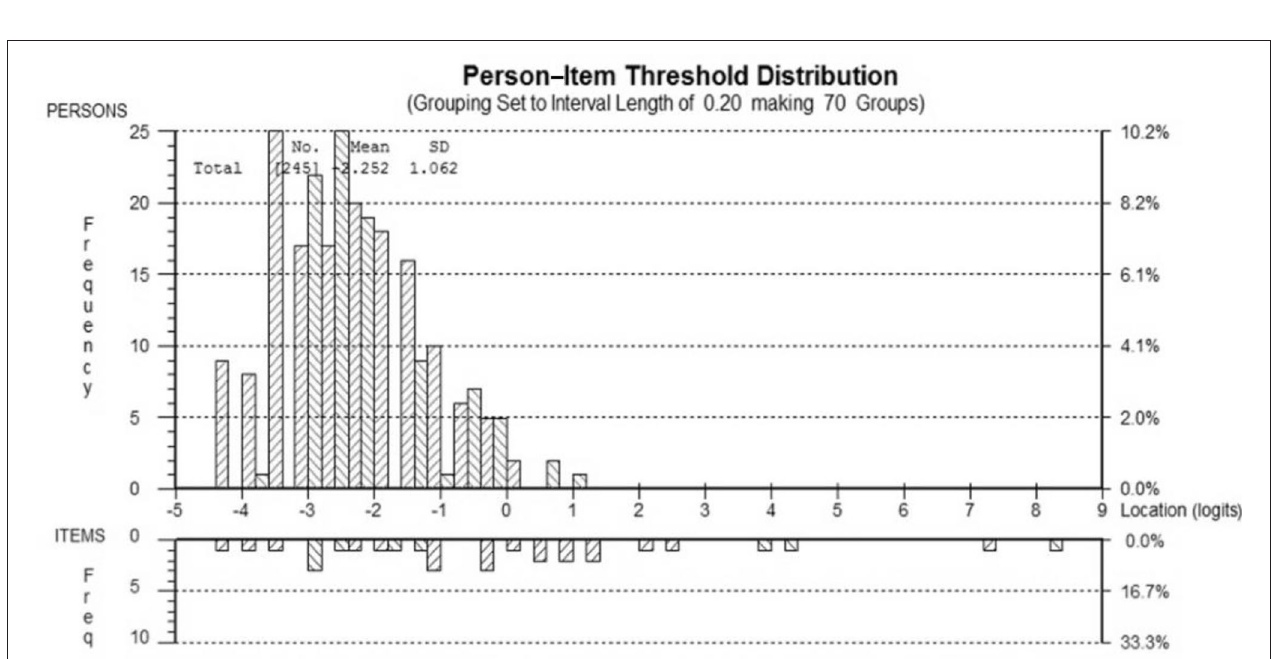
FIGURE 2 | Person–item location distribution for the EK scale. Targeting of the patient sample (top) to the EK items (bottom). The figure shows the adequate targeting between the distribution of person measurements (upper histogram) and the distribution of item locations (lower histogram). There are no ceiling/floor effects indicated by the range of the person measurements (upper histogram “blocks”) falling within the item locations (lower histogram “blocks”).